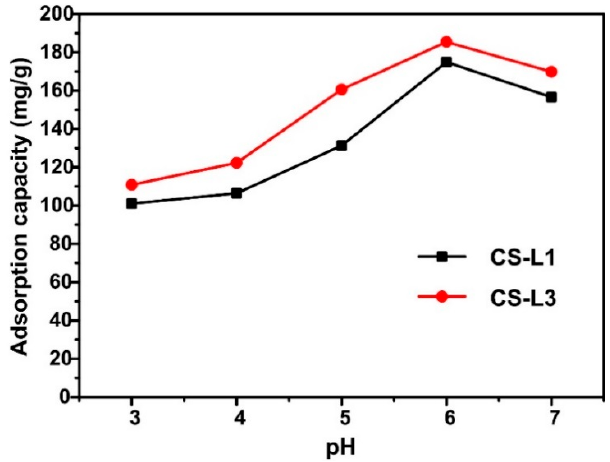
Figure 7. The influence of pH values on adsorption capacity of Cu(II).